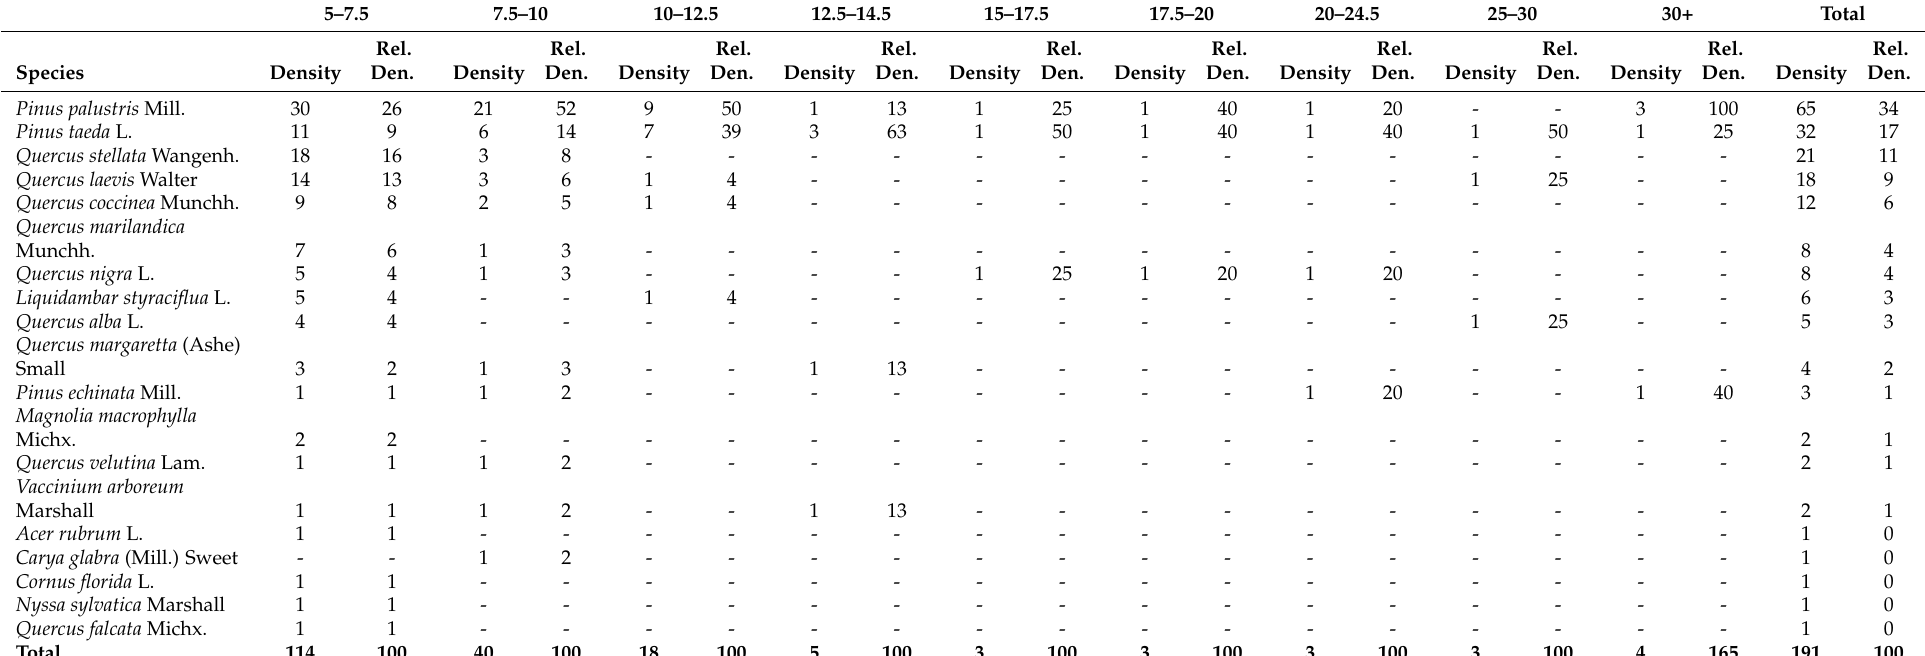
Table 1. Density (stems ha − 1 ) and relative density (Rel. Den., % of contribution) of trees (live, woody stems ≥ 5 cm dbh) by diameter bins (cm) documented in a catastrophically disturbed Pinus palustris woodland on the Oakmulgee Ranger District, Talladega National Forest, Alabama, USA. Species are ranked by total relative density.